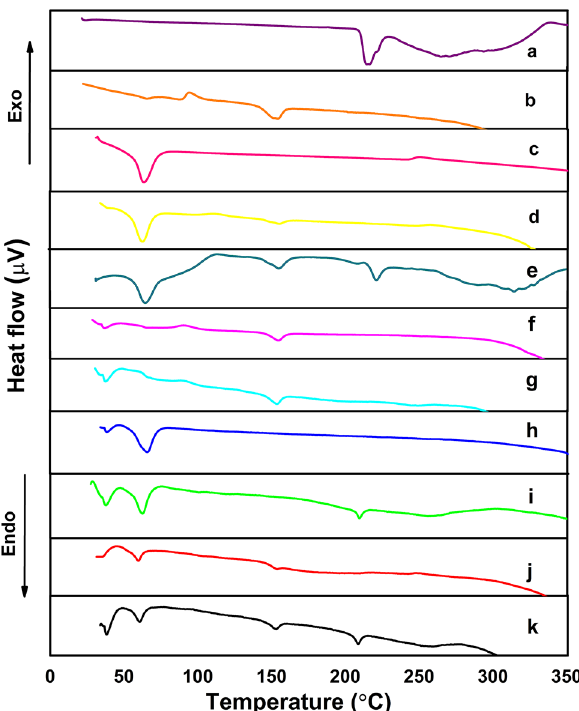
Figure 4. DSC thermograms of ( a ) VEN, ( b ) PLA cast film, ( c ) PCL cast film, ( d ) PLA/PCL blend cast film, ( e ) VEN-PLA/PCL cast film, ( f ) 10% PLA NFs (Plain), ( g ) VEN-10%PLA NFs (Medicated), ( h ) 14% PCL NFs